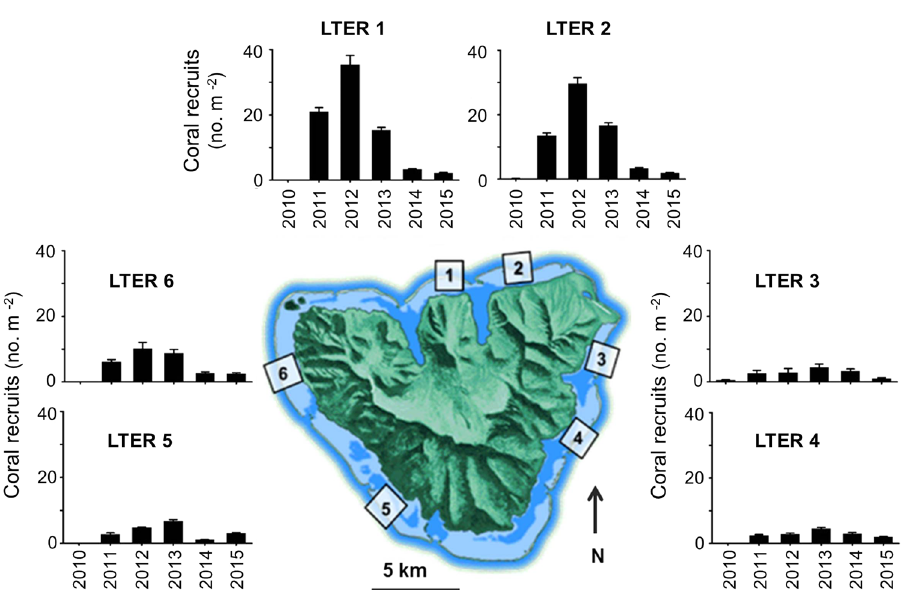
Figure 2. Spatial pattern in mean ( ± SE) density of coral recruits (colonies ≤ 3 cm diameter) at 10 m depth around Moorea based on diver surveys of 25 m 2 plots. The magnitude of coral recruitment following 2010 varied sharply among sites, and the pattern mirrors the pattern of variation in recovery of live coral cover (Fig. 1). Map of Moorea was based on an original image (ISS006-E-39837) provided courtesy of the Earth Science and Remote Sensing Unit, NASA Johnson Space Center (https://eol.jsc.nasa.gov) and was modified using Adobe Photoshop Elements v14.1 and Microsoft PowerPoint